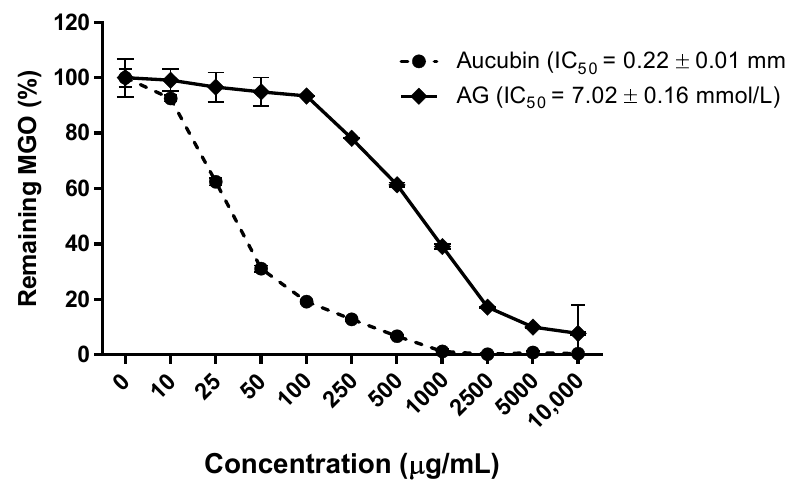
Figure 3. MGO breaking activity of aucubin and AG. All results are expressed as the mean ± SE, n = 4. The IC 50 values were determined from the plotted graph.